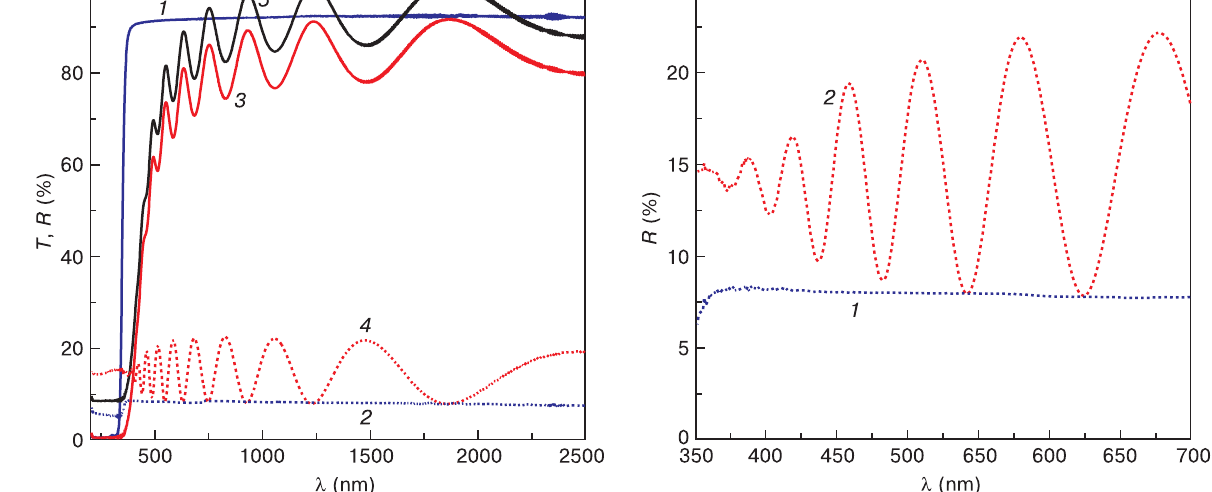
Figure 3. ( 1 , 3 and 5 ) Transmittance and ( 2 and 4 ) reflectance spectra of ( 3 and 4 ) typical structure, ( 1 and 2 ) substrate and ( 5 ) film.